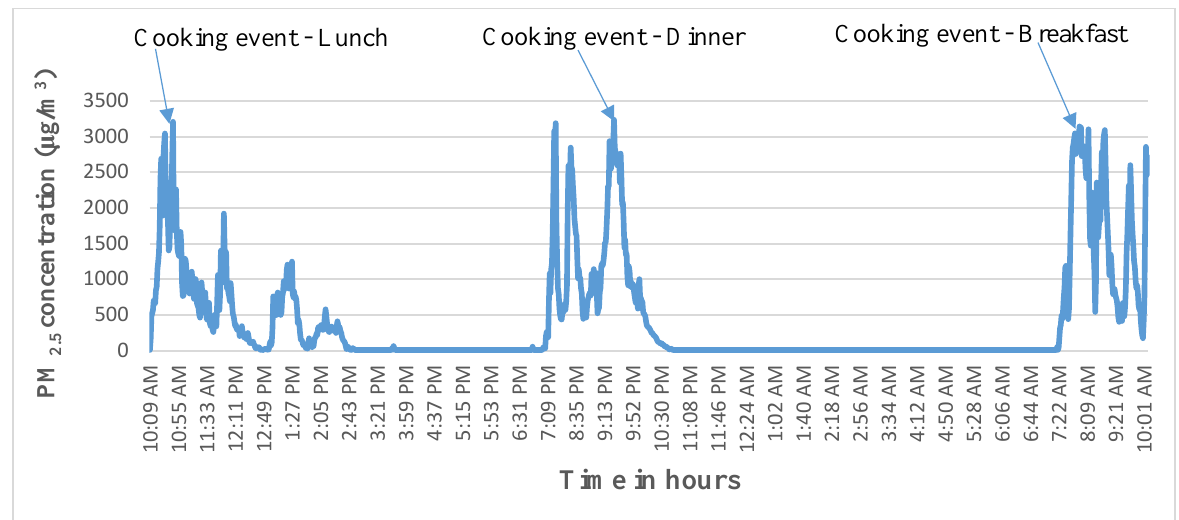
Figure 1. Results from a representative household measurement of PM 2.5 during 24 h, including cooking events as reported by the mother and peak PM 2.5 concentrations as determined by a Particle and Temperature Sensor (PATS+) instrument positioned in the cooking area.